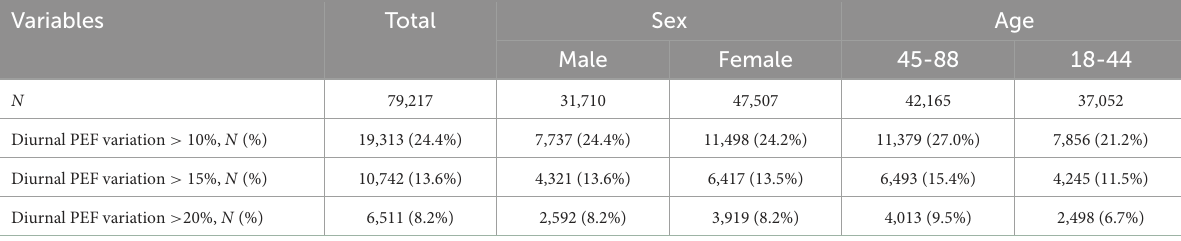
TABLE 1 Summary of diurnal PEF variations, stratified by sex and age. Variables